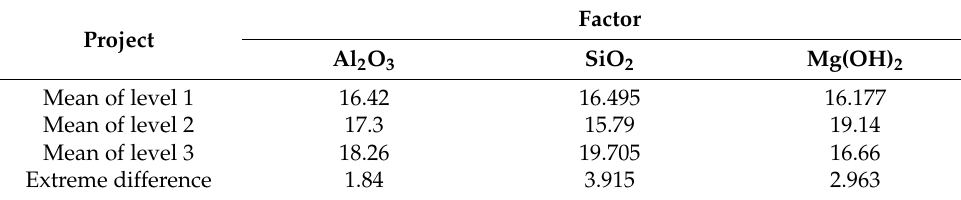
Table 8. Mean and extreme difference analysis of dielectric loss of each factor